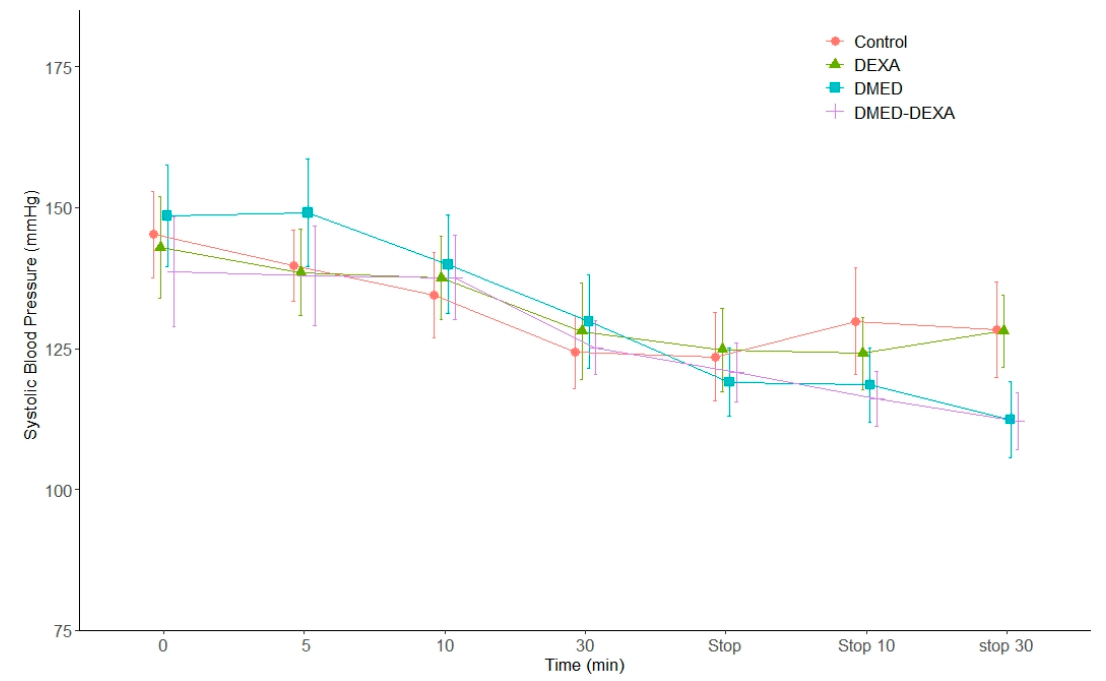
J. Pers. Med. 2021 , 11 , x FOR PEER REVIEW 12 of 13 Figure A3. Changes in systolic blood pressure during and after surgery in the four study groups. The systolic blood pressure recorded at 0, 5, 10, and 30 min after the start of sedation and 0, 10, and 30 min after the end of sedative infusion.